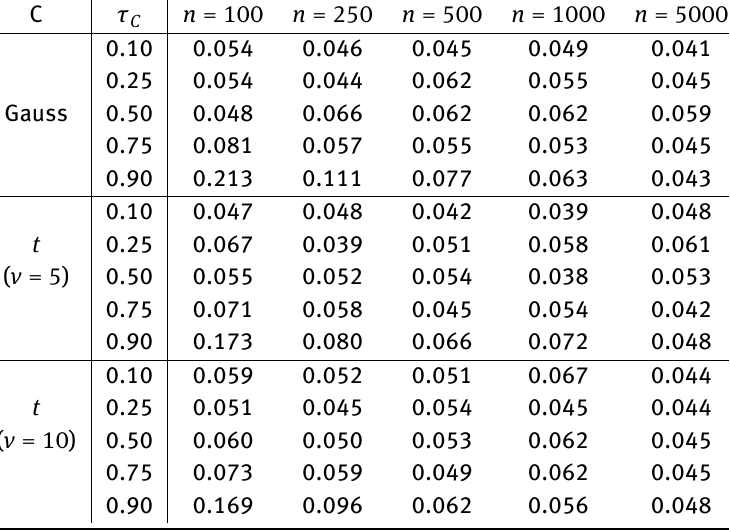
Table 4: d = 3 : Empirical level of the test for ellipticity with significance level α = 0.05 based on the test statistic T n : rate of rejecting H 0 as observed in 1000 random samples of size n from copula family C with Kendall’s tau τ C .